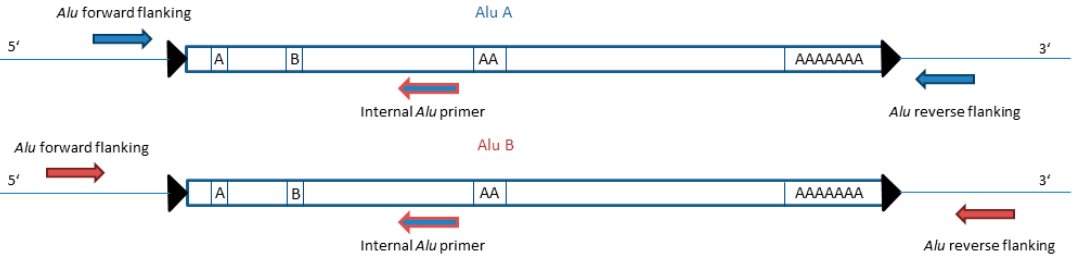
Figure 1. Schema of the Alu duplex primer positioning. The dimeric structure is separated by an A-rich linker region. The left monomer contains Boxes A and B for the RNA polymerase III. The right monomer shows the recognition site displayed by a poly-A tail. The Alu elements are flanked by target-site duplications (TSDs) represented by black triangles. The two flanking Alu primer sets are placed in slightly different locations. The different-sized amplicons can be distinguished via gel electrophoresis. The internal Alu primer is specific for the sub-subfamily Alu Ya5 and is able to bind on both Alu elements (represented by blue and red coloring)